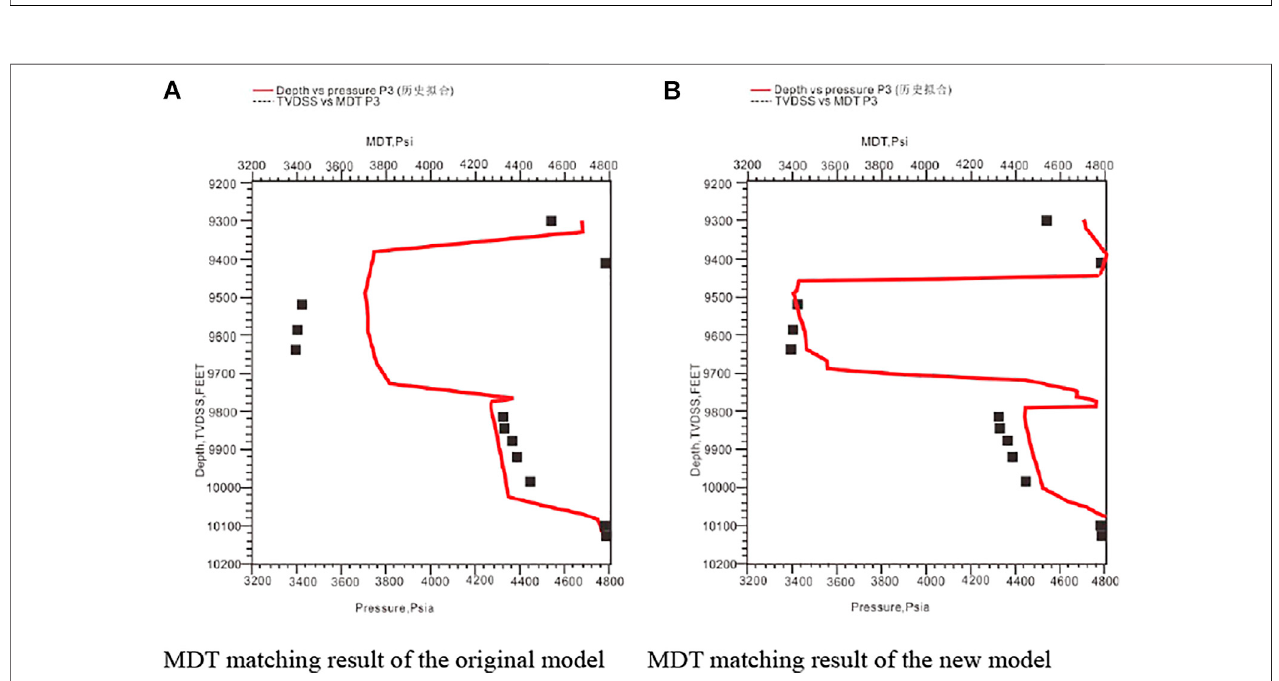
FIGURE 11 | Comparison of MDT history match of P3. (A) MDT matching result of the original model (B) MDT matching result of the new model